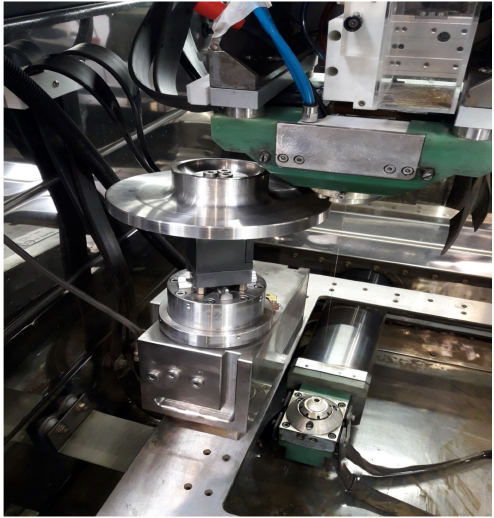
Figure 7. Set-up of the Inconel 718 prototype of the disc turbine mounted on the machine before